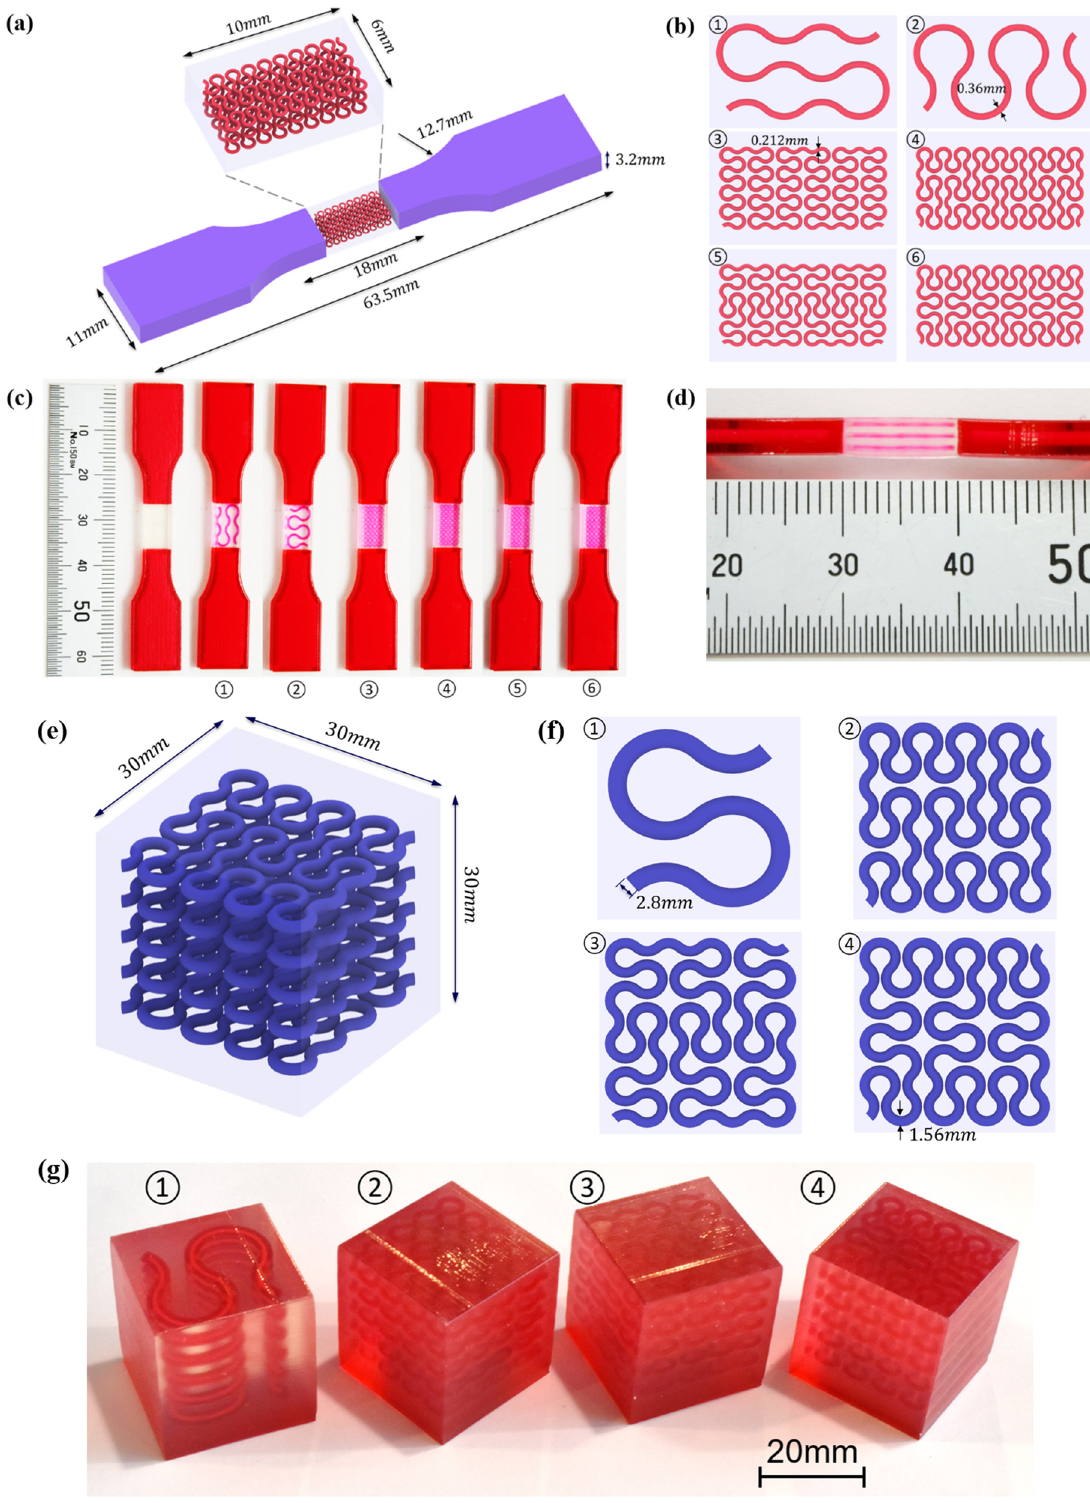
Figure 3. ( a ) Dimensions of a tensile specimen; ( b ) plan views of six different hybrid structures using different Peano patterns; ( c ) 3D-printed tensile samples, including pure A30 and composites with VMV reinforcement embedded inside A30; ( d ) side view of the gauge section for the hybrid materials, showing the three-layer reinforcement; ( e ) dimensions of the compression cube; ( f ) plan views of four different hybrid structures showing the first order reinforcement with a rein- forcement diameter of 2.8mm and 1.156 mm for all three second order designs; ( g ) pictures of 3D printed samples (from left to right, corresponds to case 1 to case 4, respectively).